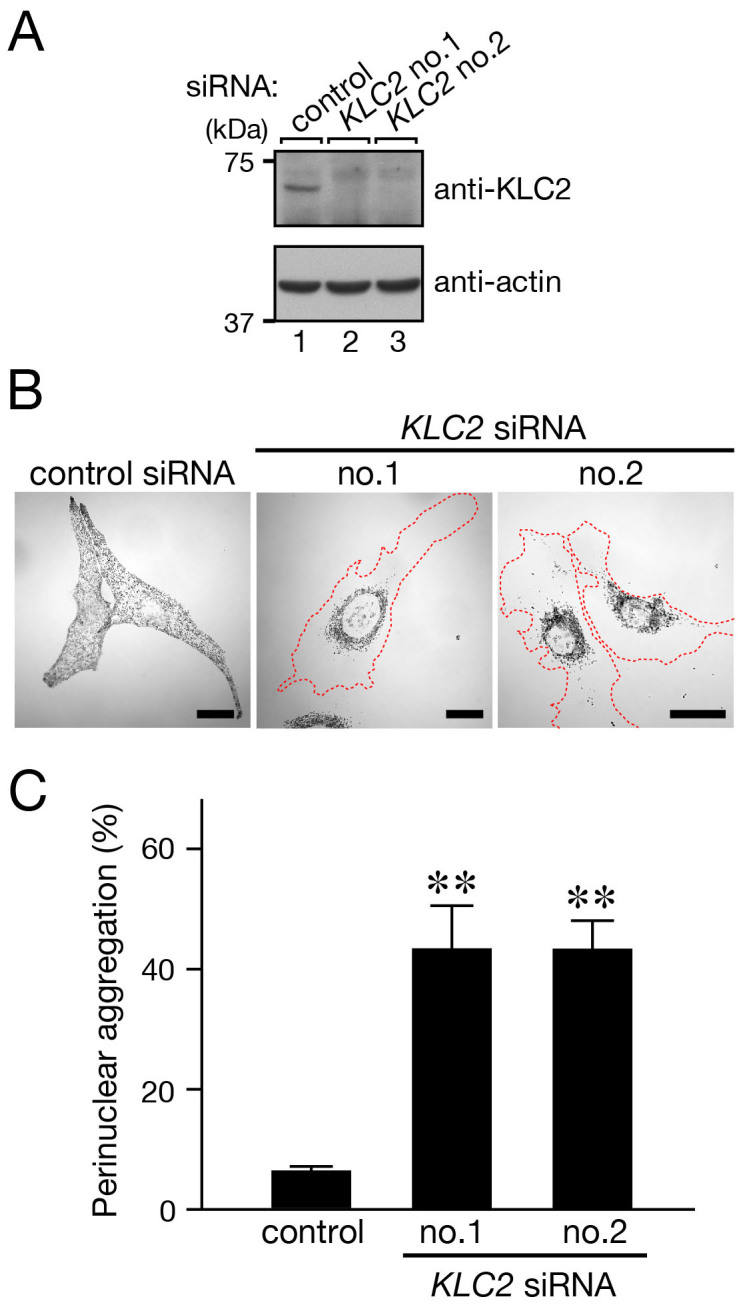
Effect of KLC2 knockdown in melanocytes on melanosome distribution.(A) Knockdown of endogenous KLC2 protein in melan-a cells with specific KLC2 siRNAs. The positions of the molecular mass markers are shown on the left. (B) Knockdown of KLC2 in melanocytes resulted in perinuclear melanosome aggregation. Melan-a cells were treated with a control siRNA (left panel) or KLC2 siRNAs (right two panels). Cells exhibiting perinuclear melanosome aggregation are outlined with broken lines. Note the clear perinuclear melanosome aggregation in the KLC2-deficient cells (right two panels). Scale bars, 20 μm. (C) Quantification of the results shown in (B). The results are expressed as the percentages of cells that exhibited perinuclear melanosome aggregation, and the bars represent the means and S.E. of the data from three independent experiments (n >100). **, p <0.01 in comparison with the control cells (Dunnett's test).